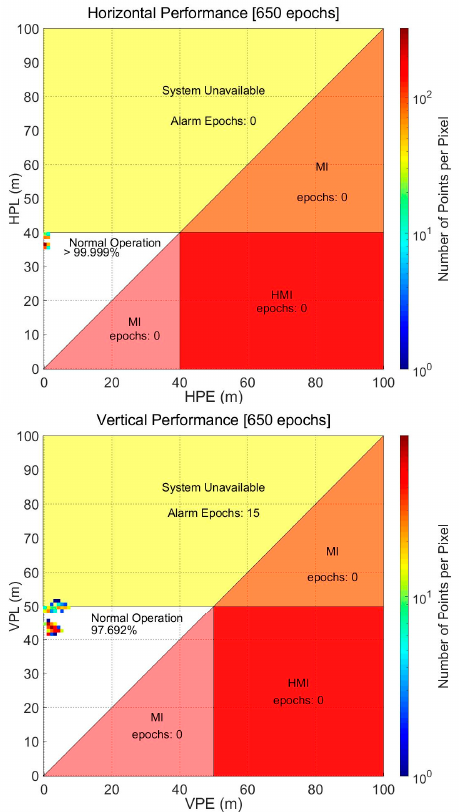
Figure 18. Horizontal ( left ) and vertical ( right ) Stanford plot for Multifunctional Satellite Augmentation System (MSAS) during drone operation (Approach with Vertical guidance, APV-I).